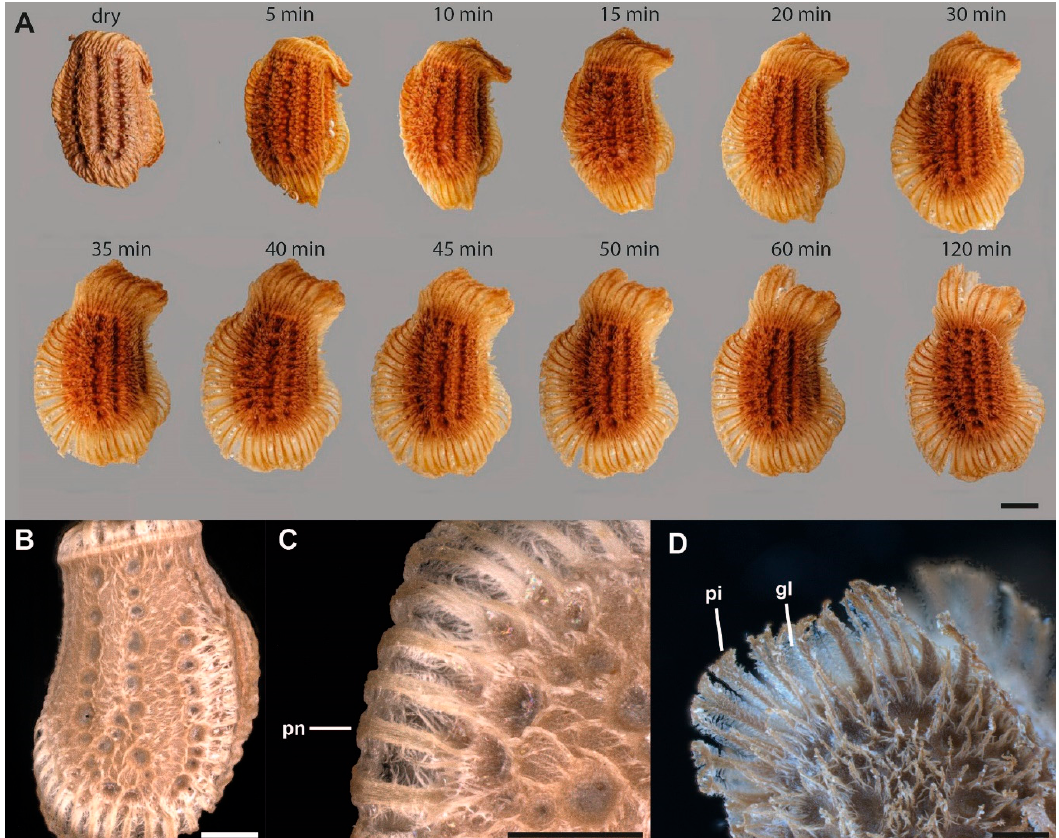
Figure 3. Unfolding behavior of Phyllium egg pinnae. ( A ) Succession of pinnae unfolding in Phyllium rubrum Cumming, Le Tirant and Teemsma, 2018, after exposure to water (images are provided by Bruno Kneubühler), lateral views. B,C. Lateral view of untreated Phyllium philippinicum egg. ( B ) Overview. ( C ) Detail of folded pinnae. ( D ) Detail of unfolded pinnae of a Phyllium philippinicum egg after water exposure. gl , glue; pi , unfolded pinna; pn , folded pinna. Scale bars: 1 mm ( A , B ), 500 µ m ( C , D